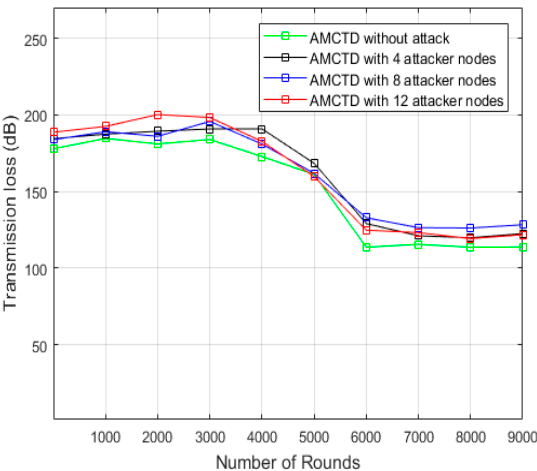
Figure 6. AMCTD: Transmission loss without attack and with 4, 8 and 12 Attacker Nodes.